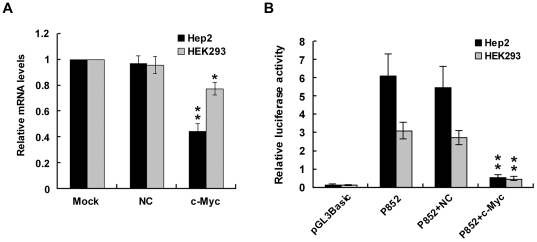
Silencing of endogenous c-Myc reduces MYCT1-TV promoter activity.
A. Detecting of c-Myc expression level in cells by qRT-PCR. The expression of GAPDH was used as an internal control. Hundred nanogram of no siRNA (Mock), nonspecific control siRNA (NC) or c-Myc specific siRNA (c-Myc) were transfected into Hep2 (black bars) or HEK293 (gray bars) cells. B. Luciferase activity of MYCT1-TV promoter after transfected with c-Myc siRNA. Luciferase activity was measured in Hep2 (black bars) or HEK293 (gray bars) extracts 48 h after transfection. pGL3-Basic, cells cotransfected with pGL3-Basic and pRL-TK; P852, cells cotransfected with P852 and pRL-TK; P852+NC, cells cotransfected with P852, NC siRNA and pRL-TK; P852+c-Myc, cells cotransfected with P852, c-Myc siRNA and pRL-TK. Data are indicated as the means ± SEM of three independent experiments.